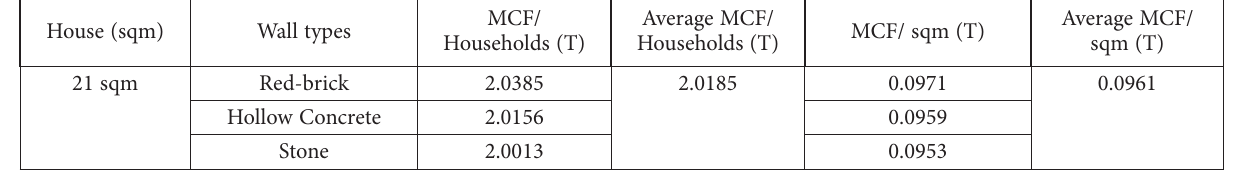
Table 5. The Average of MCF (Material Carbon Footprint) per sqm of floor area